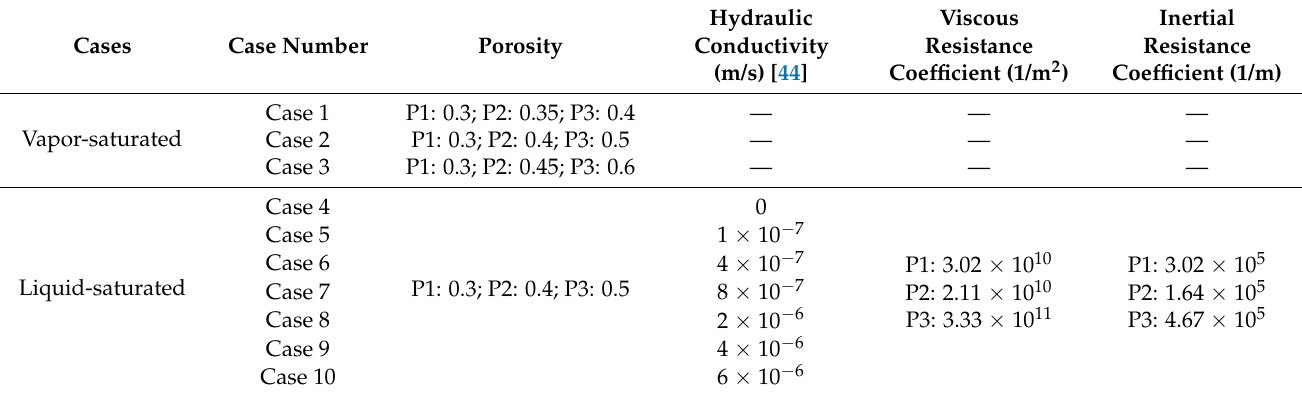
Table 3. Numerical condition parameters.